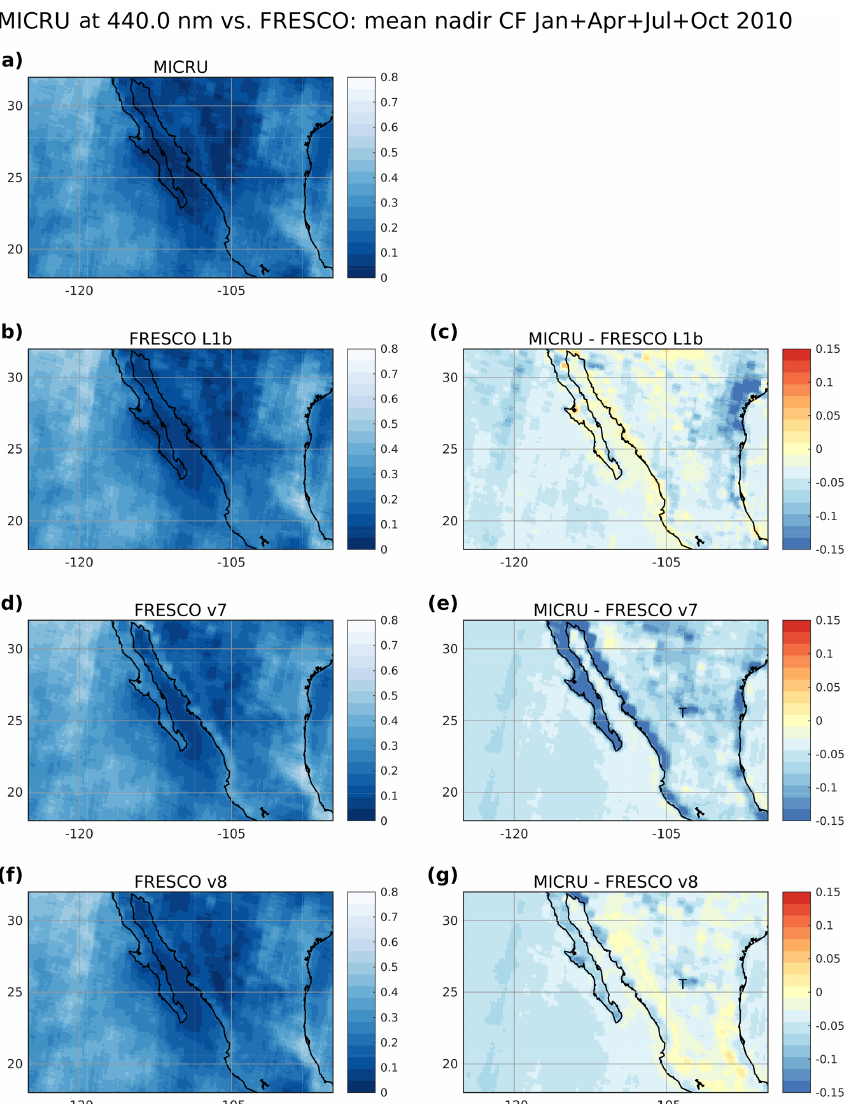
Figure 23. Comparison between average cloud fractions from different algorithms: (a) MICRU PMD channel 8 at 440nm; (b, d, f) FRESCO L1b, v7, and v8, respectively; (c, e, g) respective differences between MICRU and FRESCO. Averages include all nadir measurements ( | θ | < 23.5 ◦ , same as in Fig. 22b, e, and h, respectively) recorded in January, April, July, and October 2010. The T in panels (e) and (g) marks the location of Torreón municipality in Comarca Lagunera, Mexico (see